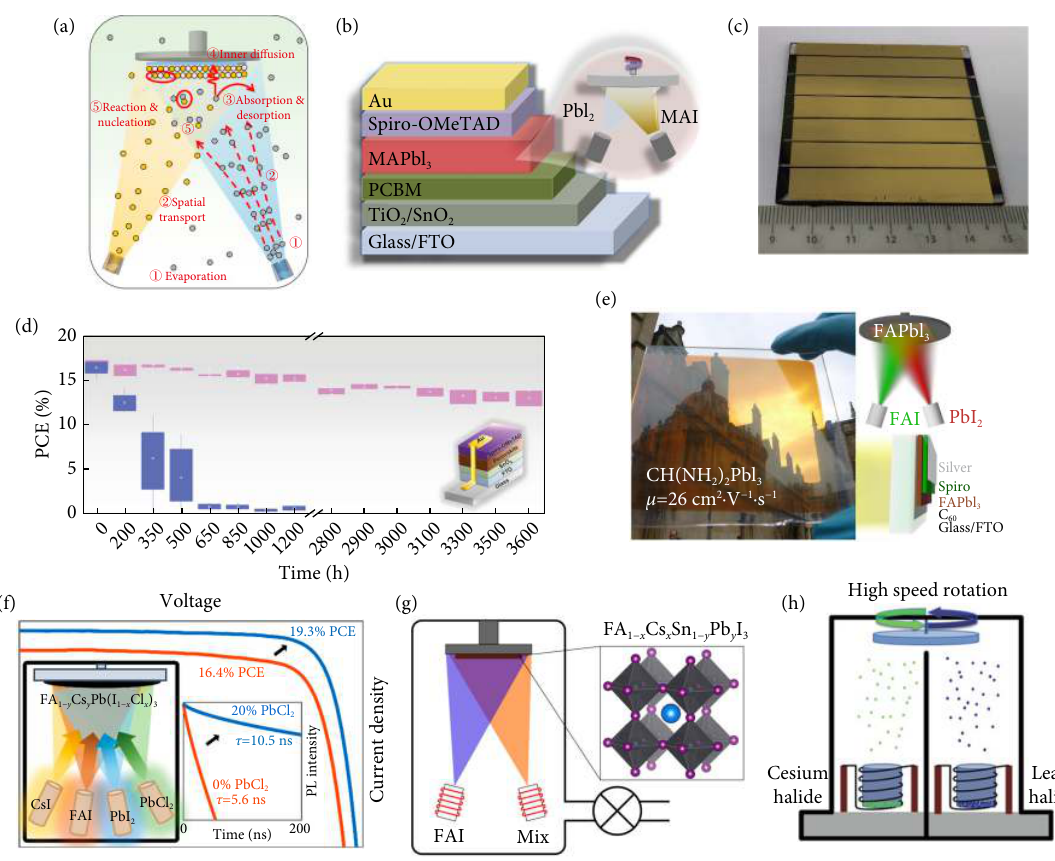
Fig. 1 Thermal coevaporation protocol for perovskite films. (a) Schematic illustration of the dual-source coevaporation method (reprinted with permission from ref. [1], © 2022 The Authors). ( b and c ) Device structure of (b) coevaporated MAPbI 3 PSCs and (c) corresponding modules (reprinted with permission from ref.